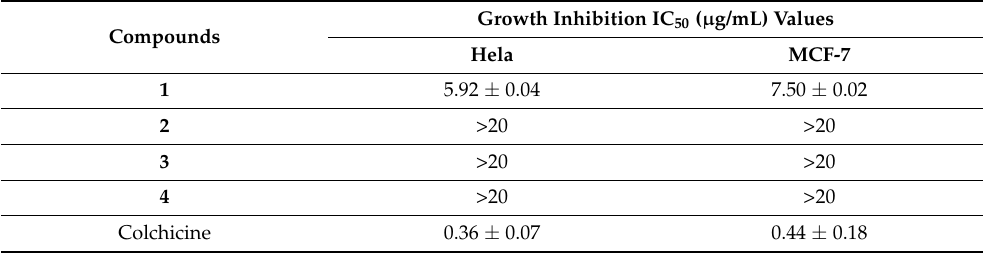
Table 5. Cytotoxic effects of new compounds ( 1 – 4 ) on human cancer cell